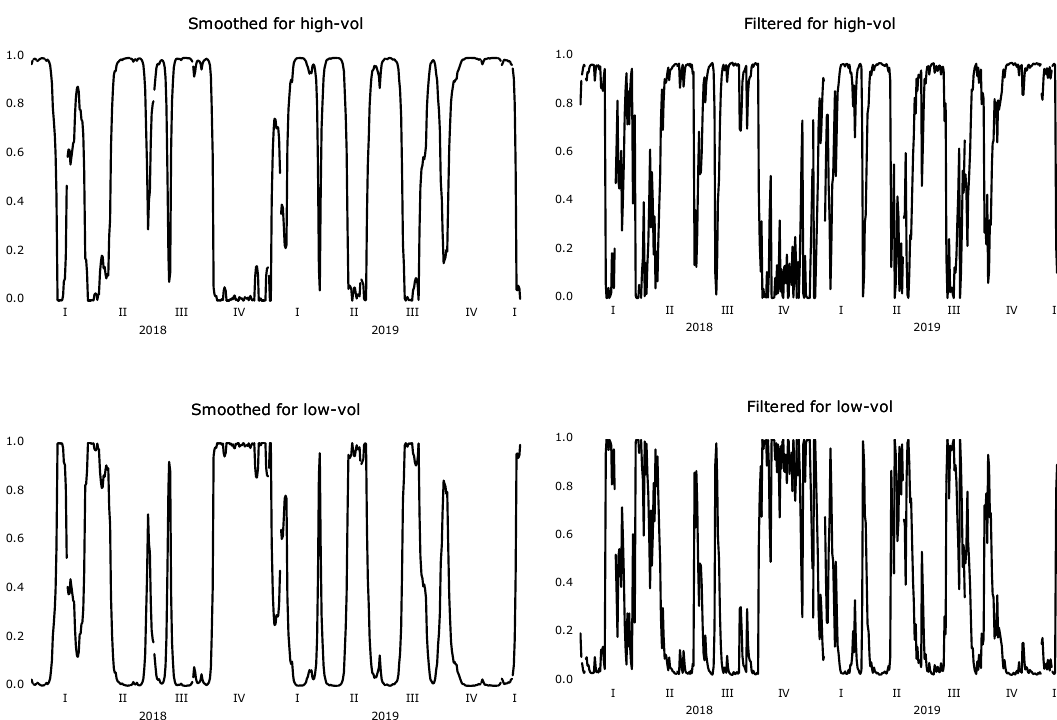
Figure 5. Computed smoothed probabilities and filtered conditional volatilities for FTE.